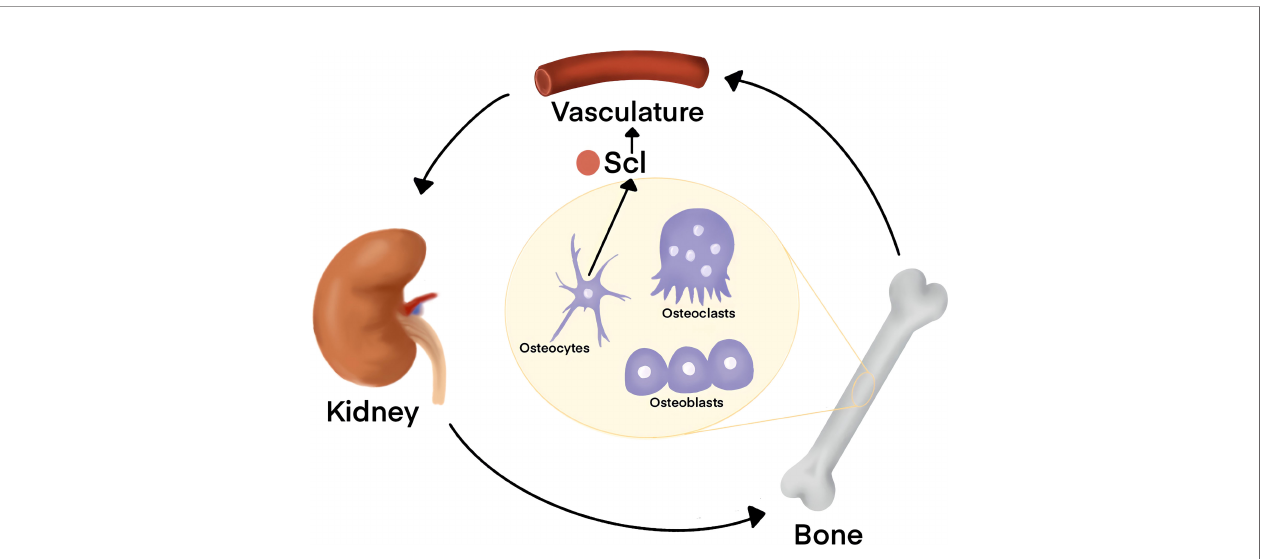
FIGURE 5 | Organ crosstalk between bone and kidney is tightly regulated by Wnt signaling. Kidneys sense the levels of serum metabolites such as Phosphate and Calcium. When Calcium levels are low, Parathyroid Hormone (PTH) is released from the parathyroid, located on the posterior aspect of the thyroid gland on the bilateral superior and inferior poles, and orchestrates bone remodeling for metabolic homeostasis. Sclerostin (Scl) is secreted from osteocytes and antagonizes Wnt signaling in osteoblasts to decrease bone formation rates. In chronic kidney disease (CKD), elevated Scl in circulation is associated with worse patient outcome. Further, elevated serum Scl was even reported to occur prior to renal disease onset, suggesting that factors secreted from the bone may drive